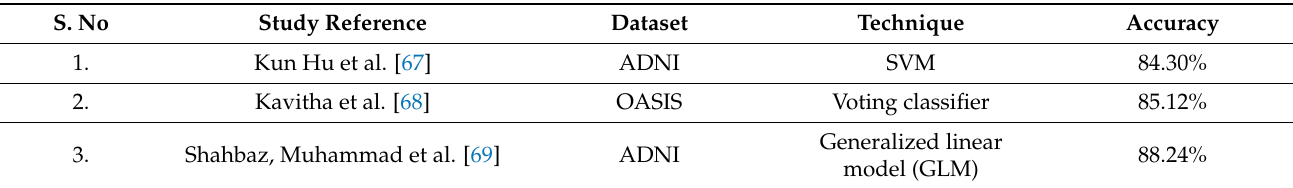
Table 10. Comparative analysis of presented models with previous